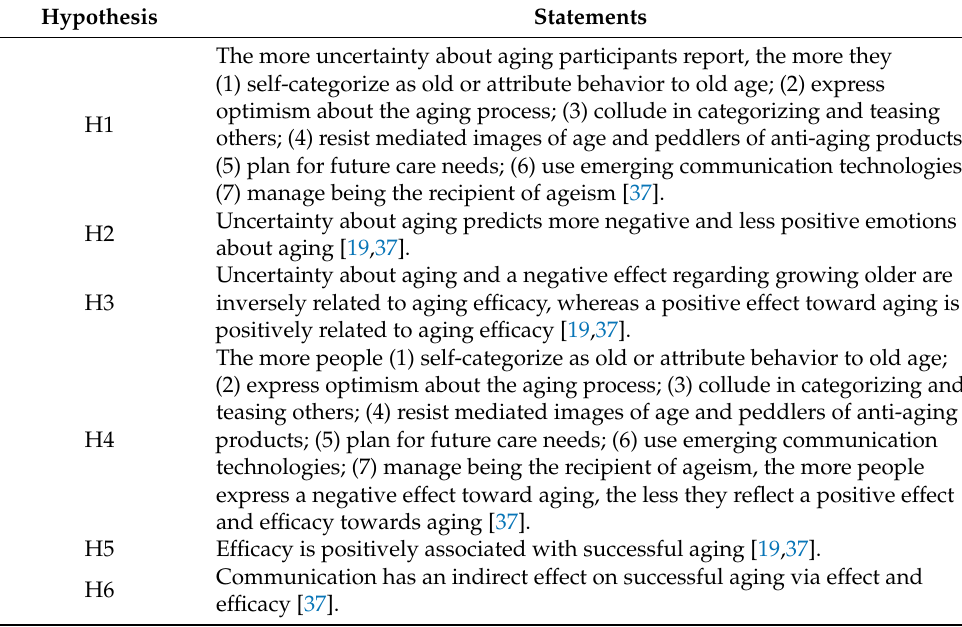
Table 1. The existing hypothesis based on previous study of original CEMSA.